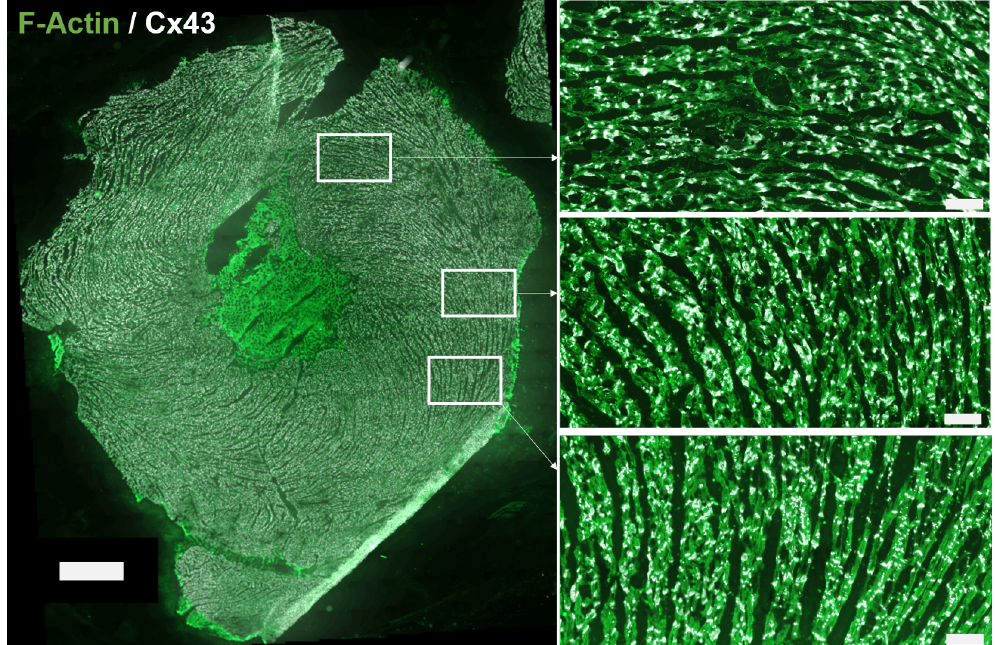
Figure 2. Image of a left ventricular rat tissue partly analyzed in this study (left) and three insets at higher magnification (right). Green signal represents F-actin (channel c 1 ). White signal is CX43 (channel c 2 ). Within the myocardium, black background estimates the interstitium (channel c 3 ). Scale bar: left, 1000 µ m; right insets, 100 µ